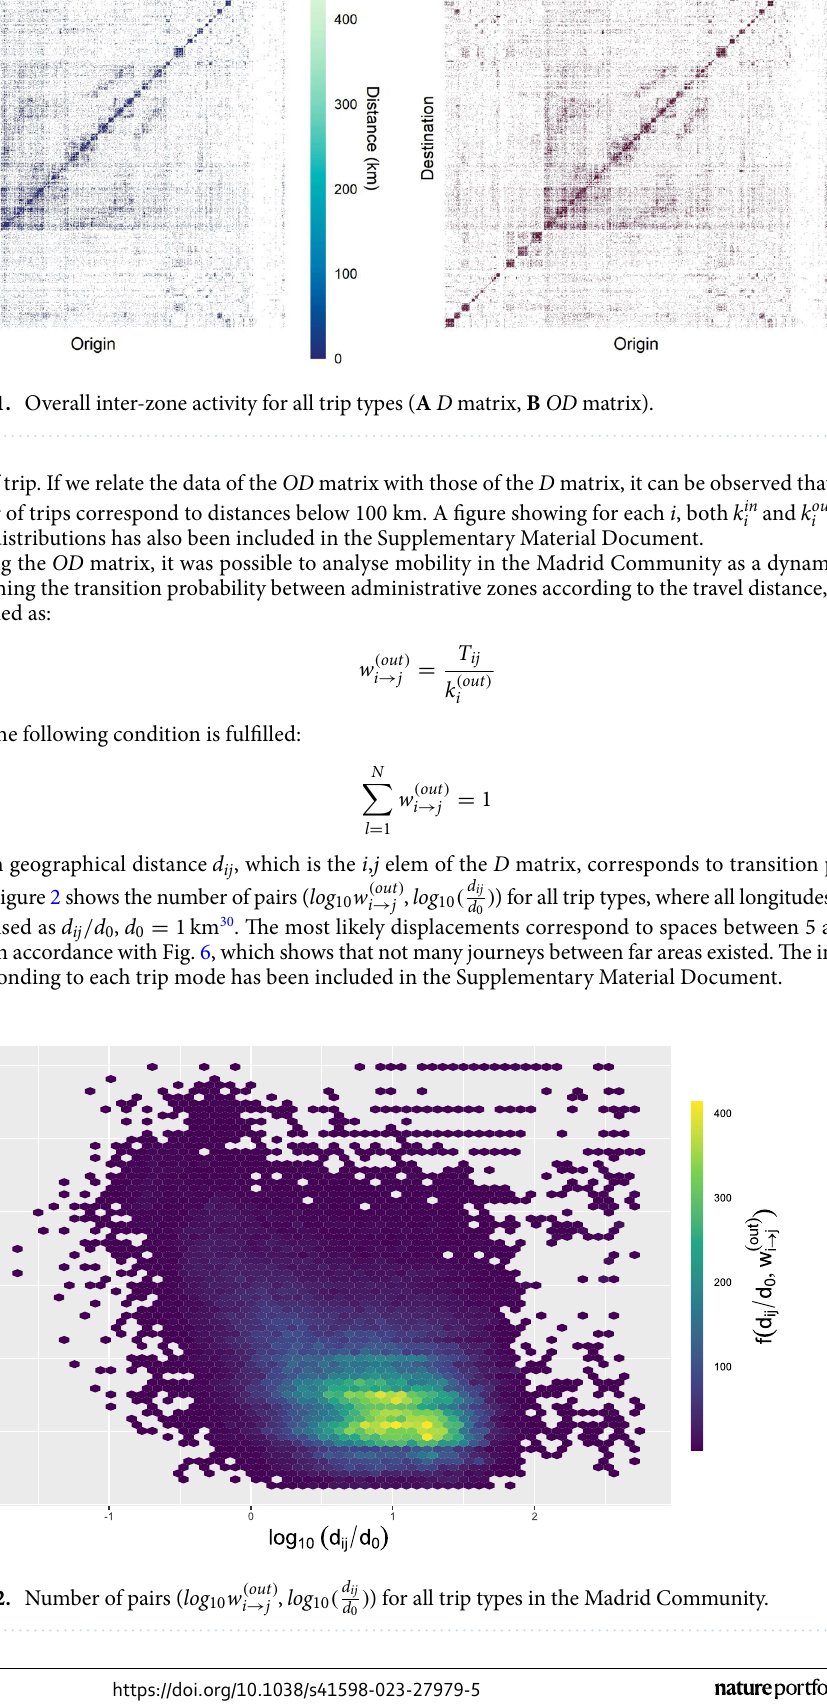
Figure 2. Number of pairs ( log 10 w